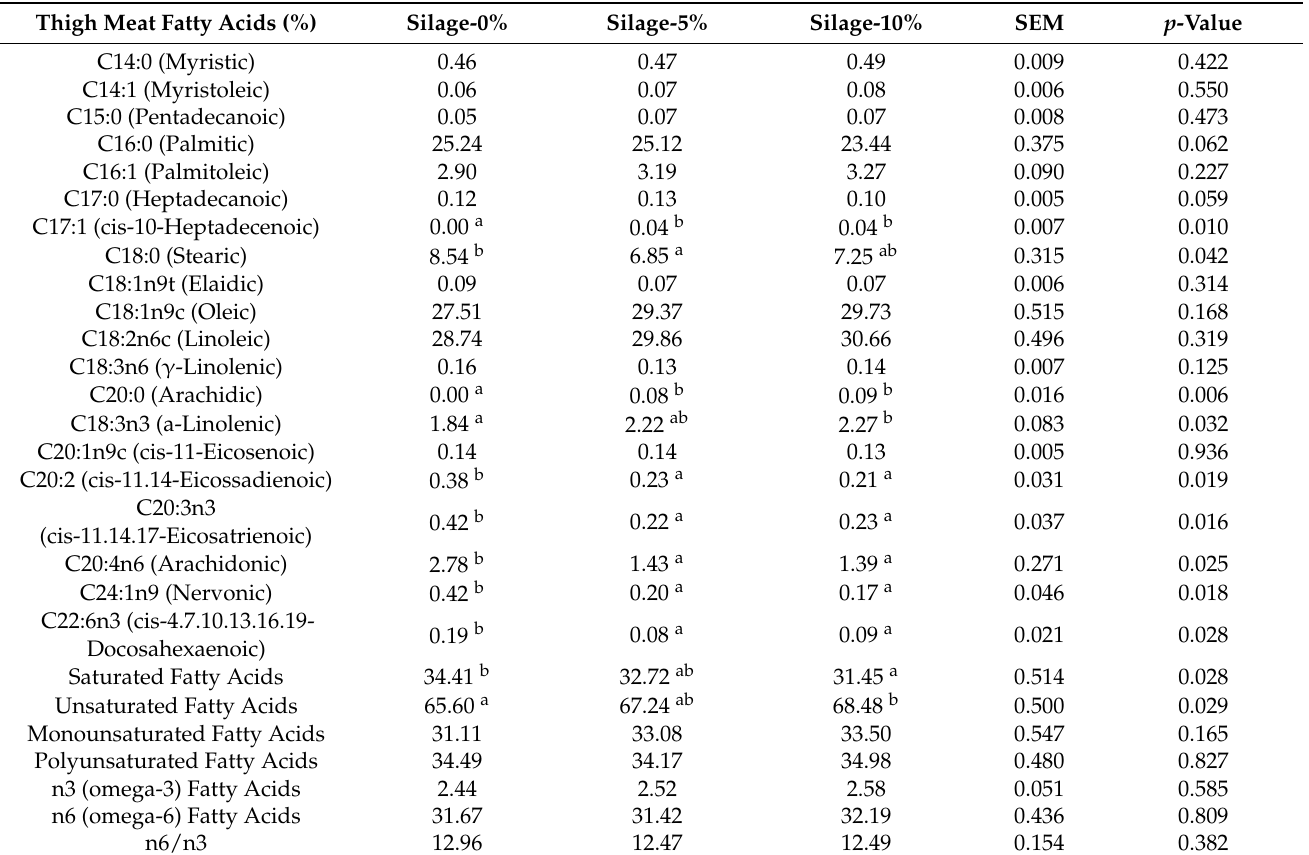
Table 10. Effect of silage supplementation on broiler thigh meat fatty acid